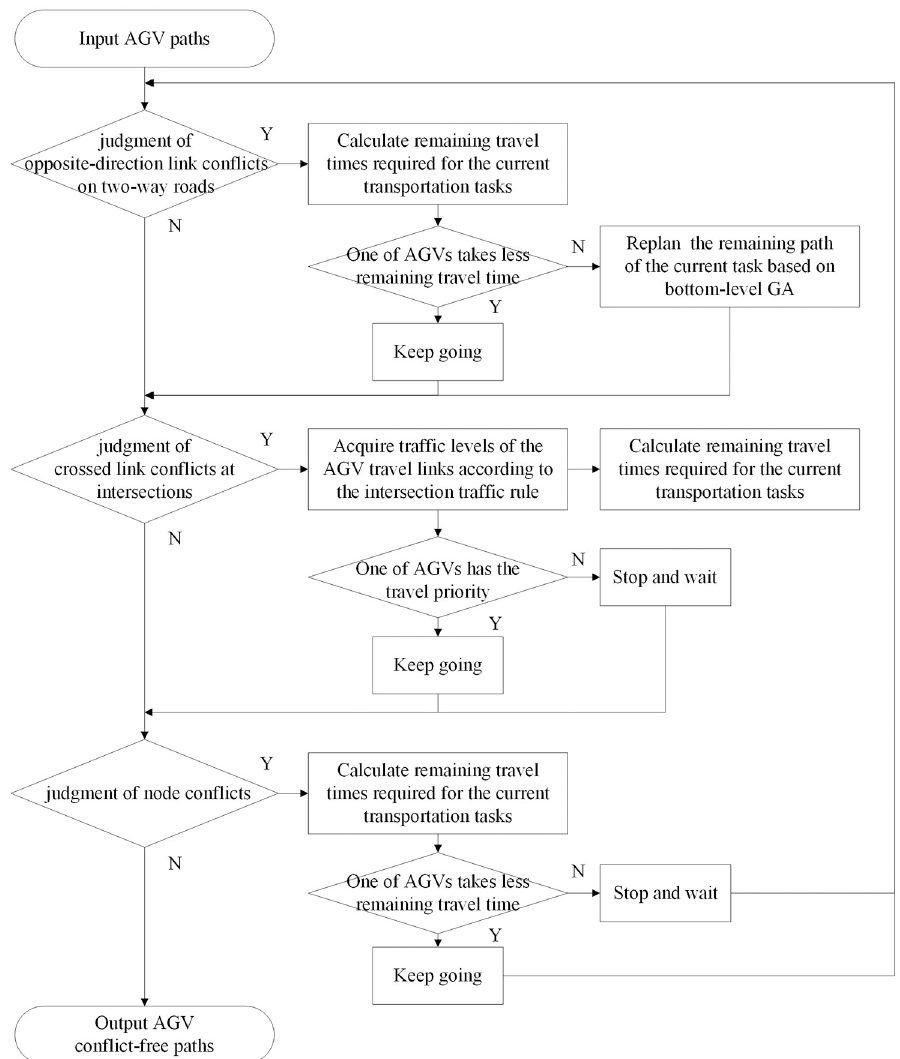
Fig 14. Flow chart of the operation of the conflict resolution rule